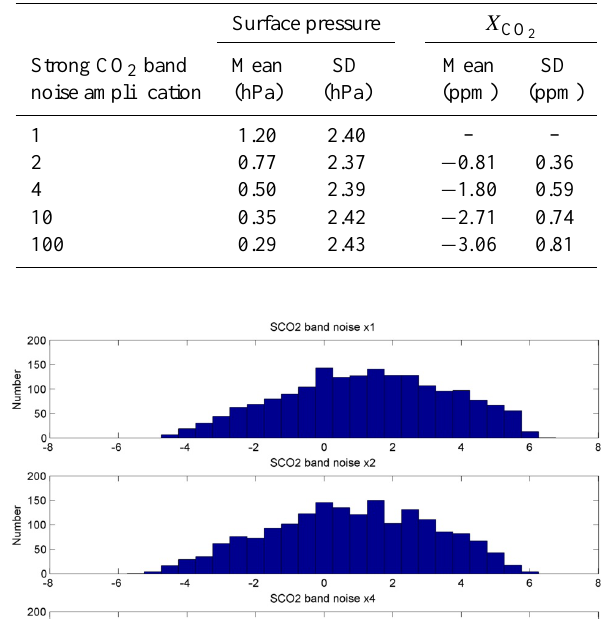
Fig. 10. Annual cycles in X CO (other colours), the latter with increasing noise in the strong CO 2 band.